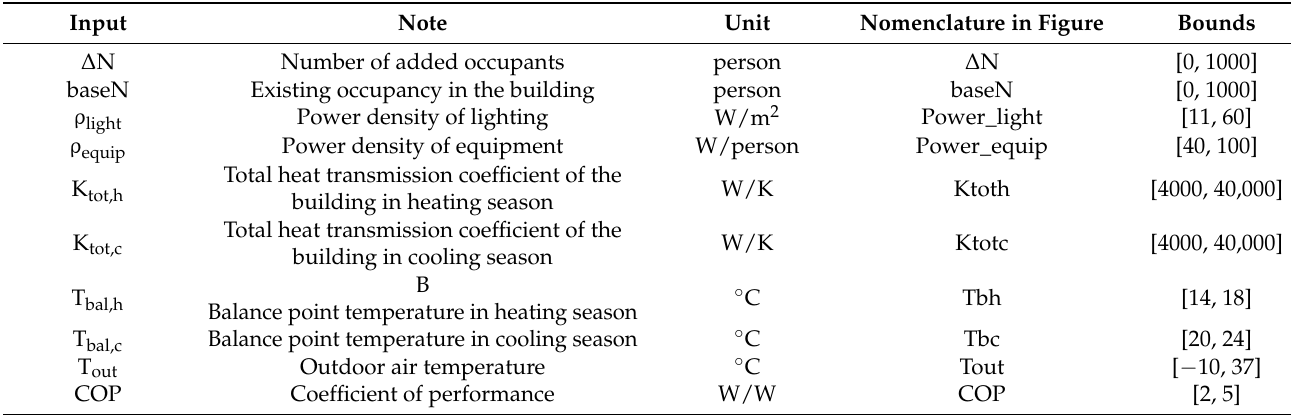
Table 3. Bounds of inputs in sensitivity analysis.